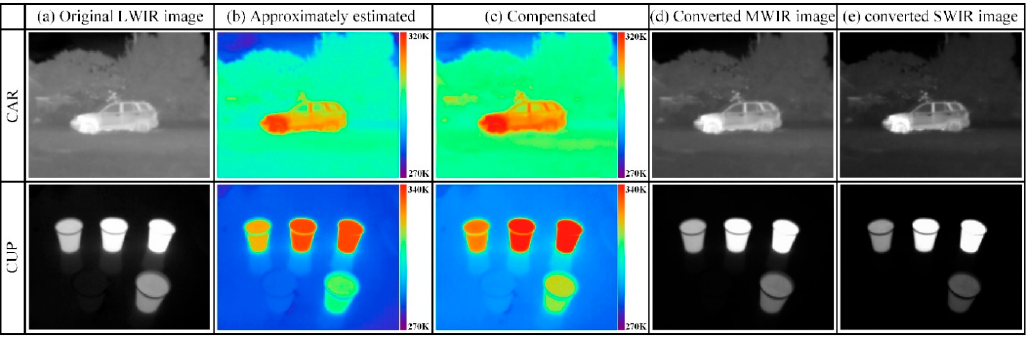
Figure 9. ( a ) Original LWIR image, ( b ) approximately estimated temperature, pseudo color image of ( c ) compensated temperature, ( d ) converted MWIR image, and ( e ) converted SWIR image for CAR and CUP.